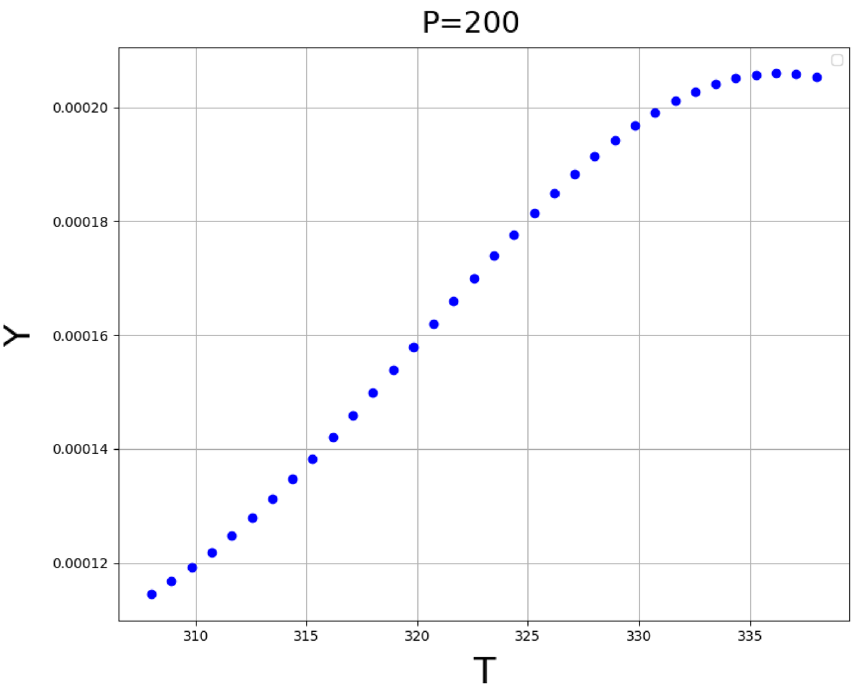
Figure 5. Trend of variable T (temperature, K) calculated using GPR model (Y: solubility, mole